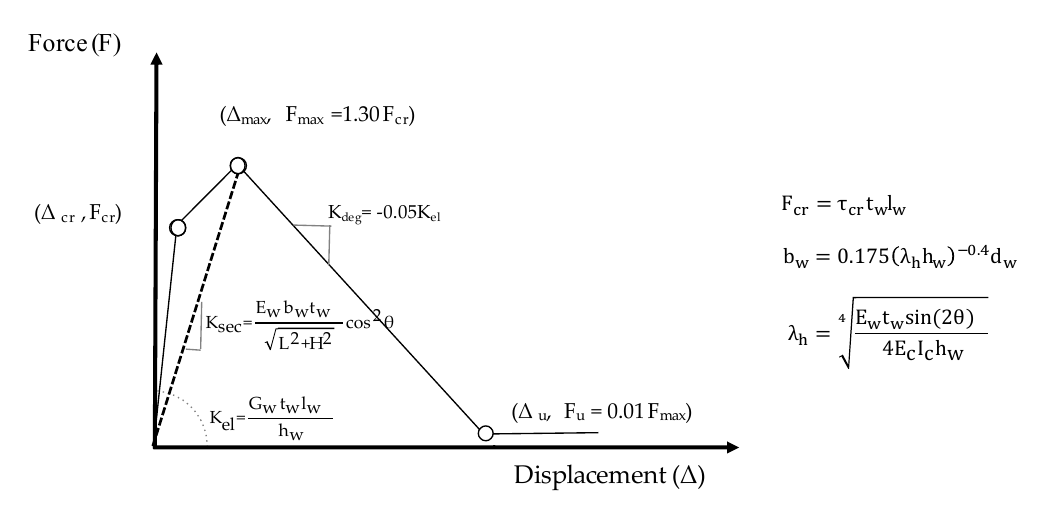
Figure 3. Lateral force–displacement relationship for infill panels.